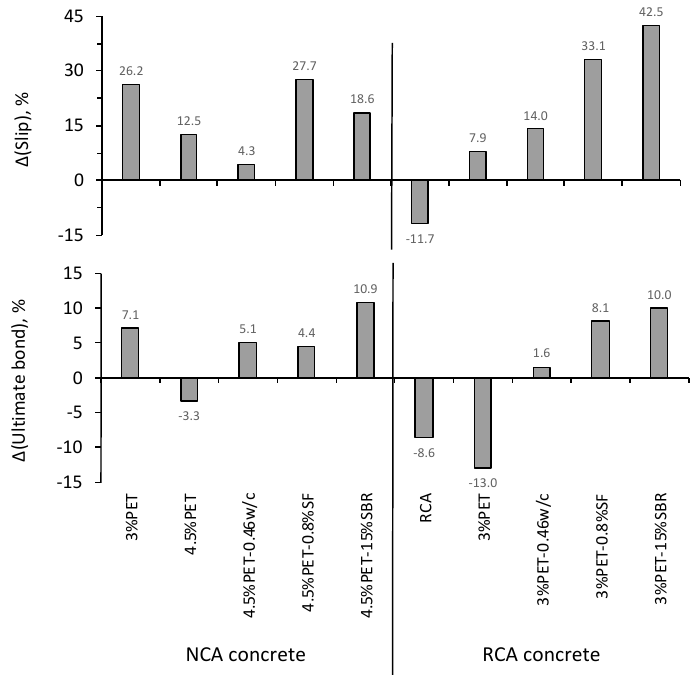
Figure 9. Effect of concrete modification on ∆ ( τ max ) and ∆ (Slip) for NCA and RCA